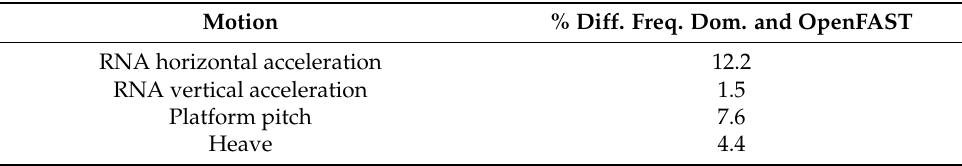
Table 27. Comparison of frequency domain model and OpenFAST